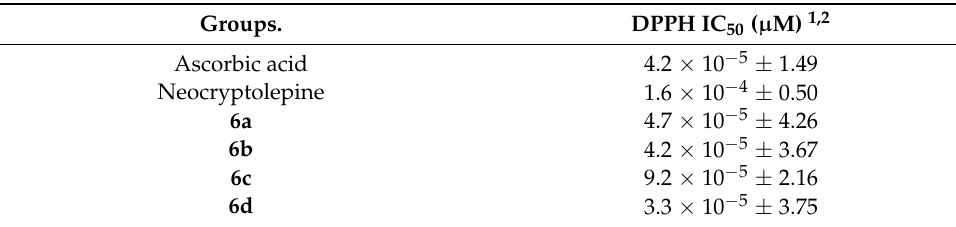
Table 2. Determination of the in vitro antioxidant activities of indoloquinoline analogs using 2, 2-diphenyl-1-picrylhydrazyl (DPPH) photometric assay.